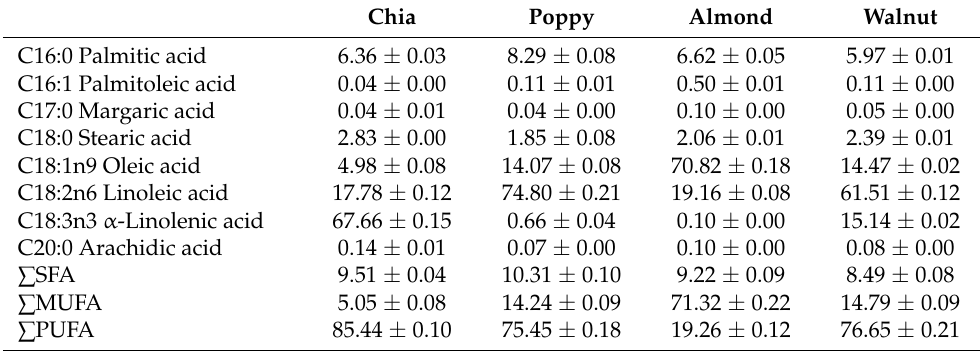
Table 2. Chemical composition of the